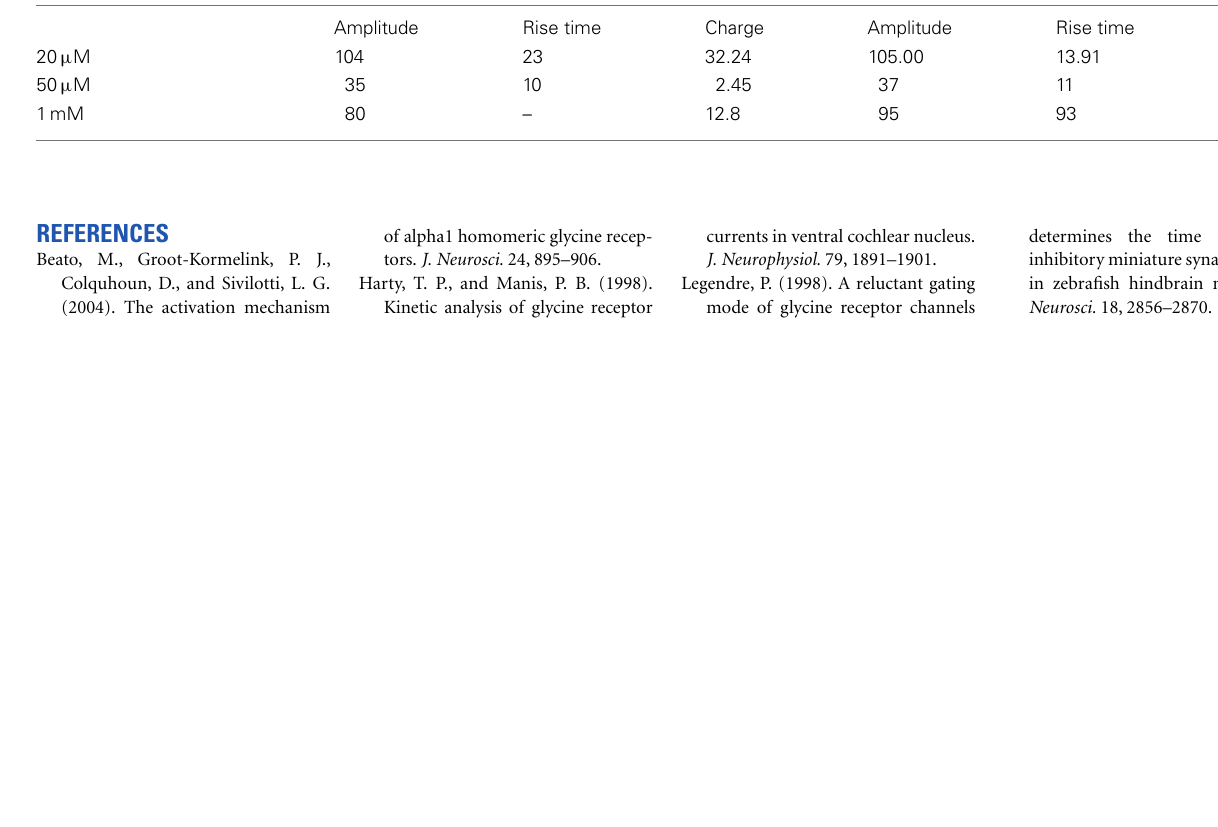
TableA2 | The effects of 2-AG (1 μ M) on I Gly at different concentration of glycine. ED, experimental data; MS, model simulation. Glycine concentration ED (%) MS